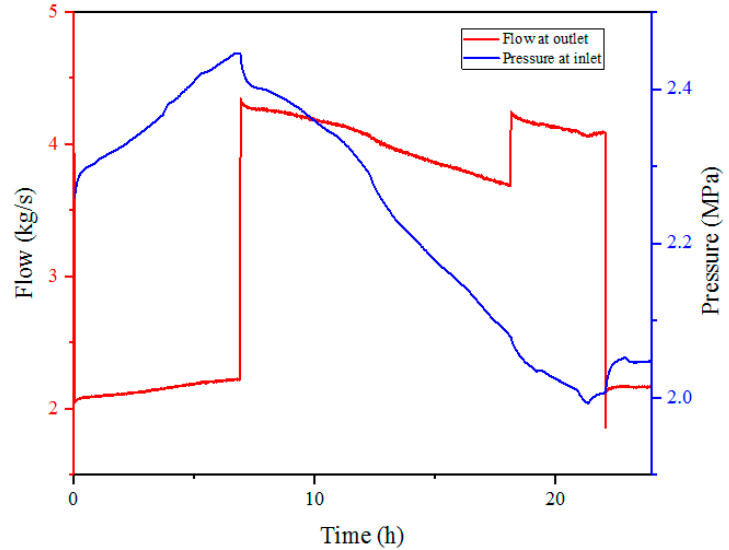
Figure 6. The boundary conditions of the XB pipeline.